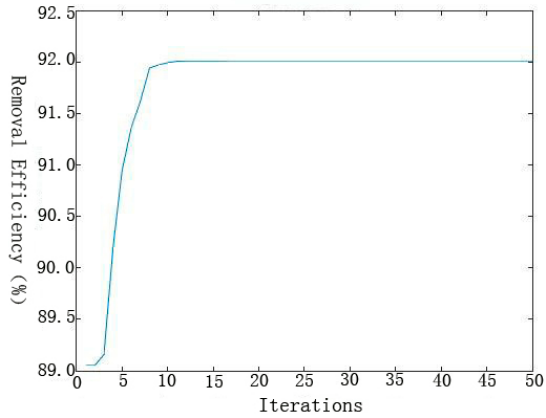
Figure 9. The maximum removal efficiency against iterations.